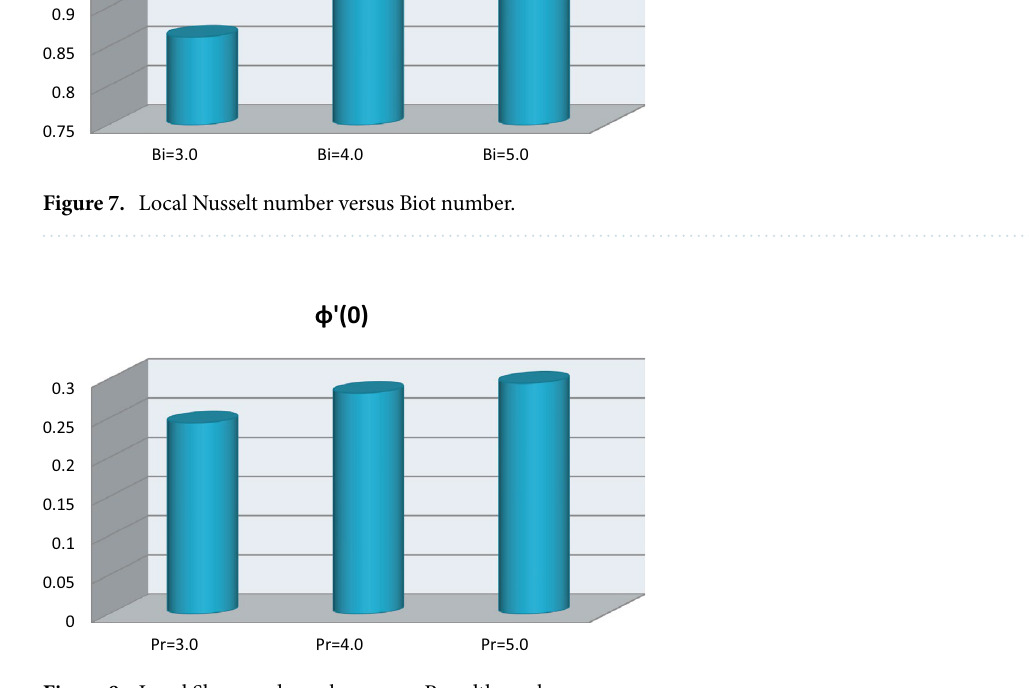
Figure 8. Local Sherwood number versus Prandtl